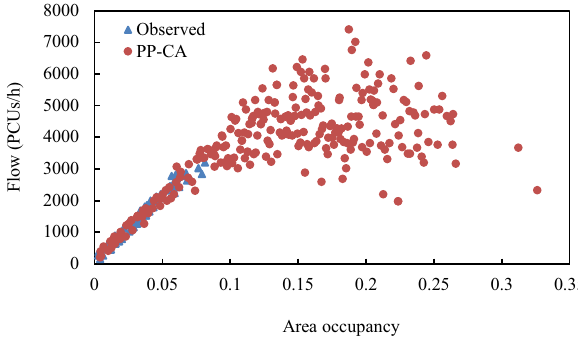
Fig. 9 Fundamental diagram comparing PP-CA model simulations and observed traffic flows